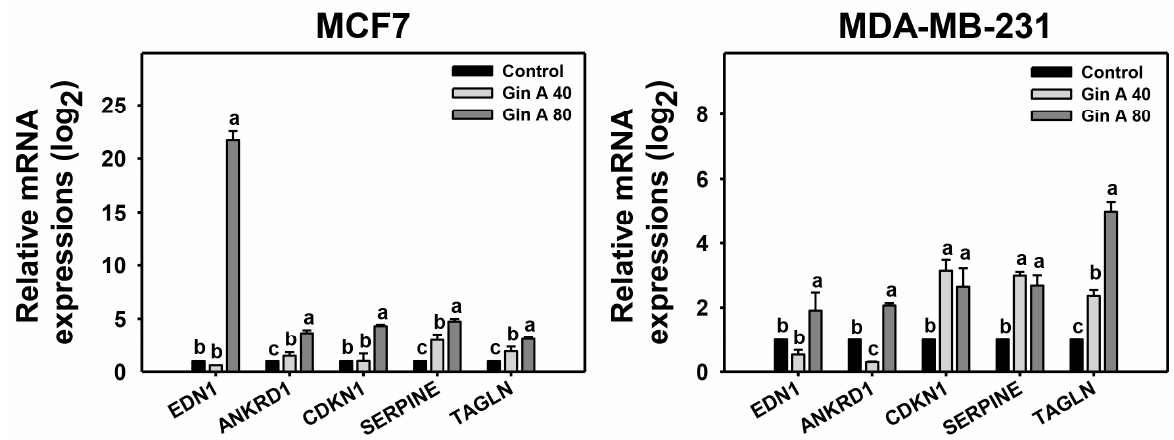
Figure 6. Impact of Gin A on senescence-associated gene expressions of breast cancer cells. Cells were treated with 0 (0.1% DMSO; control), 40, and 80 µ M Gin A for 48 h, namely Gin A 40 and Gin A 80. Subsequently, the mRNA expressions of senescence-associated genes were examined by qRT-PCR. Data, means ± SDs ( n = 3). When the connecting letters are overlapping, it means that their difference was significant for multiple comparisons ( p < 0.05 to 0.0001). For the example of the EDN1 gene in MCF7 and MDA-MB-231 cells, control and Gin A 40 showing b differ non-significantly. Gin A 80 showing a differs significantly from control and Gin A 40 showing b because they do not overlap with the same letter, i.e., a vs. b . For the example of the TAGLN gene in MCF7 and MDA-MB-231 cells, control, Gin A 40, and Gin A 80 showing c , b , and a differ significantly.